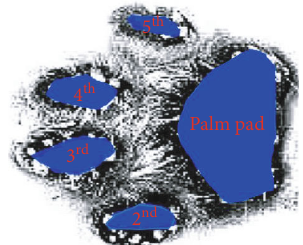
Figure 2: The paw pad of the